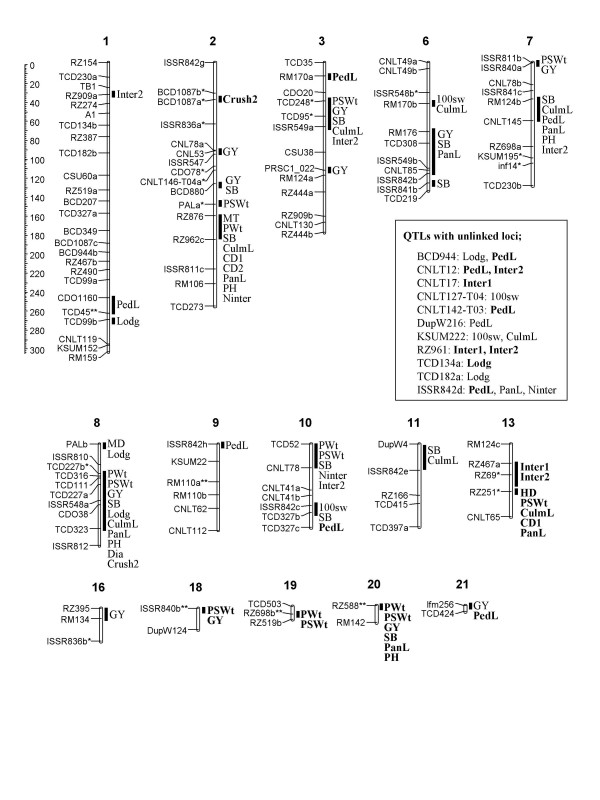
Molecular linkage map with positions of QTLs for 19 traits on tef RIL population; E. tef × E. pilosa (30-5). The genetic distance in centimorgans (cM) is given on the left at the top. Six linkage groups are not presented because they did not contain significant QTLs. QTLs with the increasing effect contributed by E. pilosa (30-5) are in boldface.